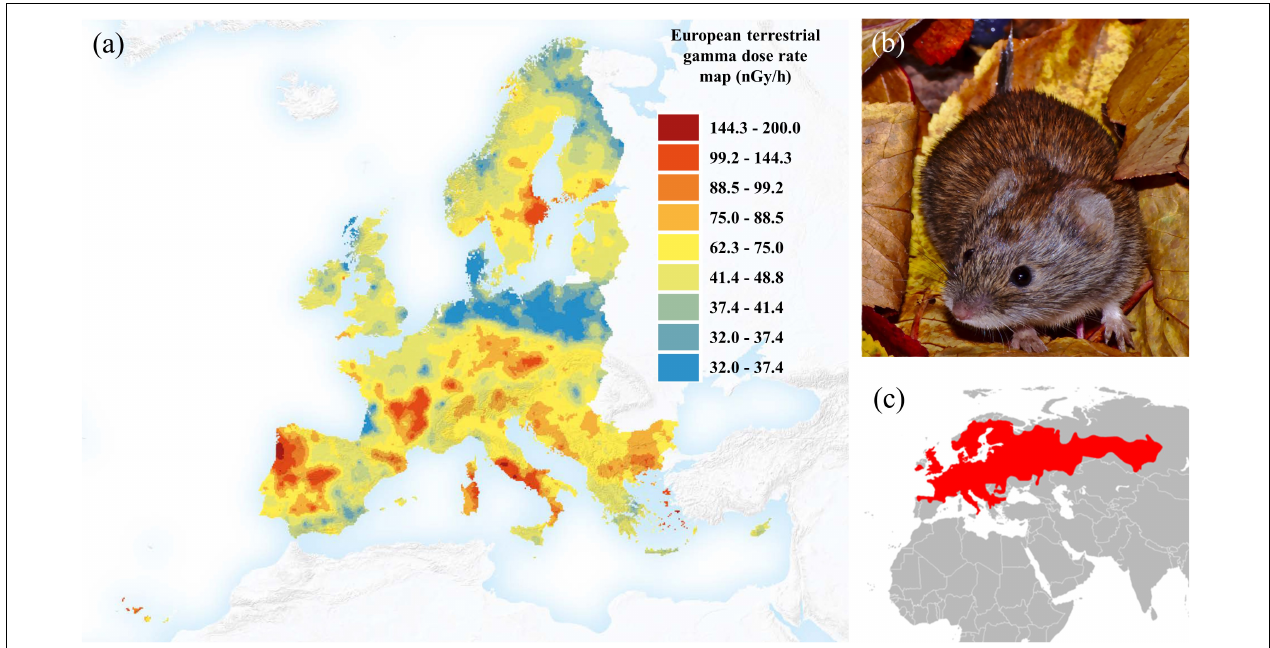
FIGURE 1 | Panel (a) shows the dose rate, in nGy/h that a person would receive from terrestrial radiation if he/she spends all the reference time in a location outdoor in which the soil has fixed U, Th and K concentrations (modified based on Cinelli et al., 2019). Panel (b) shows the study organism, the bank voles Myodes glareolus (picture by Z. Boraty´nski), while panel (c) displays the distribution range of M. glareolus across most of Europe, shown in red (data from